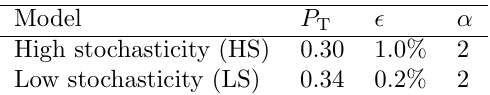
Fig. 1. Radial profiles of the SFR standard deviation of the 2-D models. The SFR standard deviation was calculated in radial bins of 1 kpc in width for the galaxy ages from 10 to 13 Gyr with a time step of 10 Myr. Table 2. The parameters of 2-D models